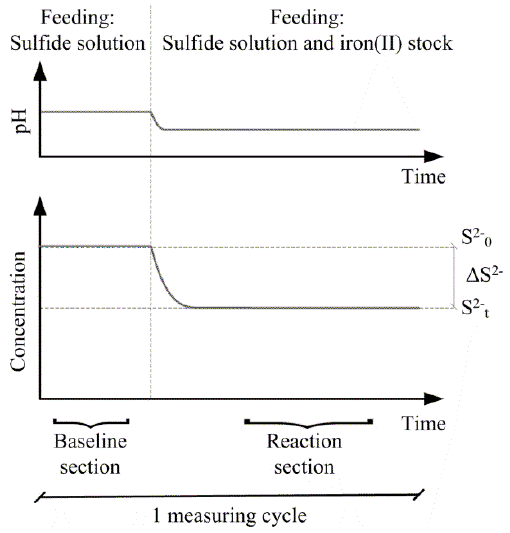
Figure 2. Schematic drawing of one measurement cycle of sulfide precipitation using ferrous iron.